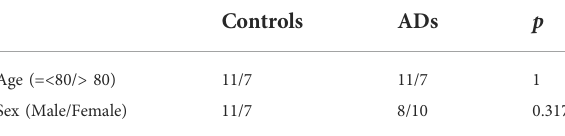
TABLE 2 Characteristics of the entorhinal cortex tissue in AD and control samples after propensity score